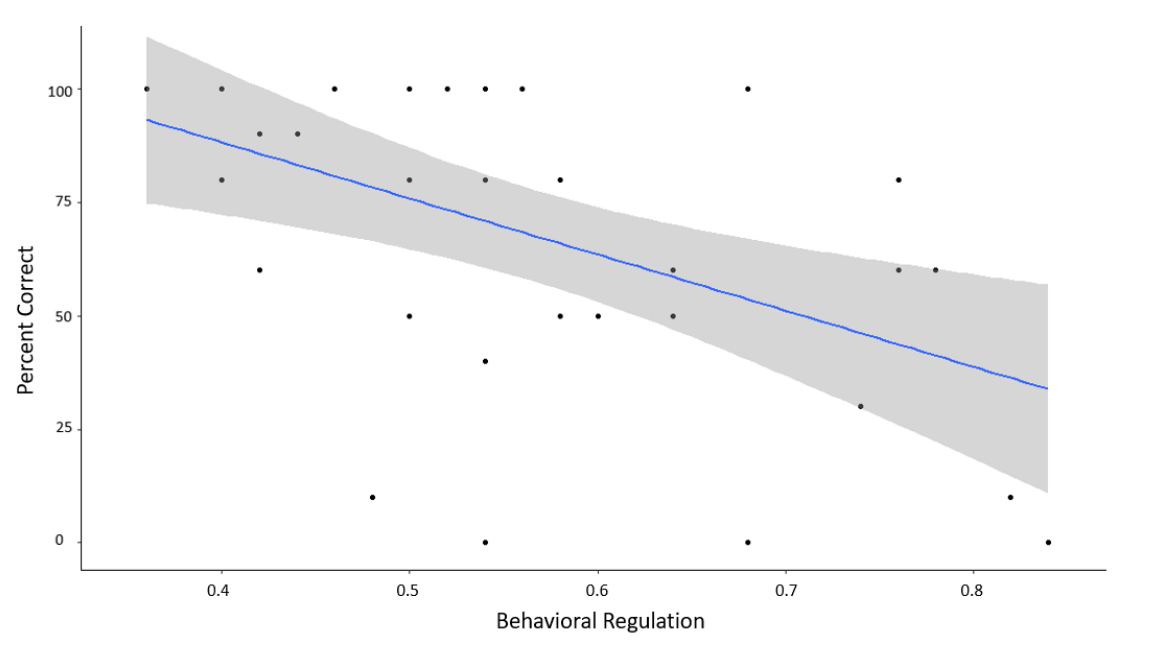
Cylinder Task Performance as Predicted by the